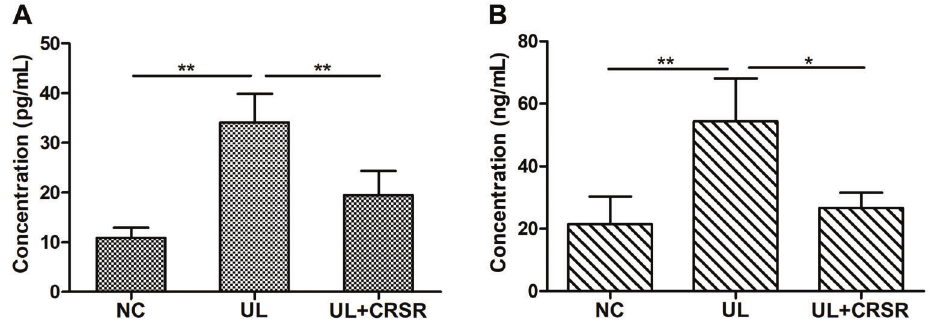
Figure 3. Effects of Curcumae rhizoma-Sparganii rhizoma (CRSR) treatment on the key hormones of uterine leiomyomas (UL): A , estradiol (E 2 ); B , progesterone (P). Data are reported as means ± SD. NC: normal control, n=10; UL: uterine leiomyomas, n=8; UL + CRSR: treatment group, n=10. *P o 0.05, **P o 0.01